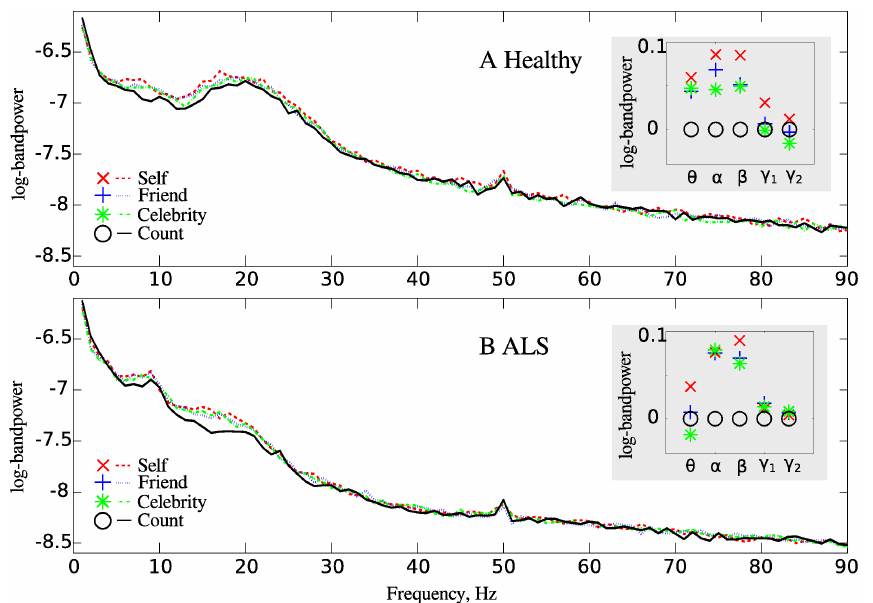
Fig 3. Mean MPFC log-bandpower is modulated by the conditions “self”, “friend”, “celebrity”, “count”. A. Healthy individuals, and B. ALS patients. Inset plot shows for every frequency band the modulation of the mean log-bandpowers in the self-referential conditions relative to the control (“count”) condition. The mean log-bandpower is averagedover subjectsand trials for every frequency band. γ 1 indicateslow γ and γ 2 indicateshigh γ . Note that modulations relativeto the control conditionwere used only for visualisation(and not for the ANOVA).